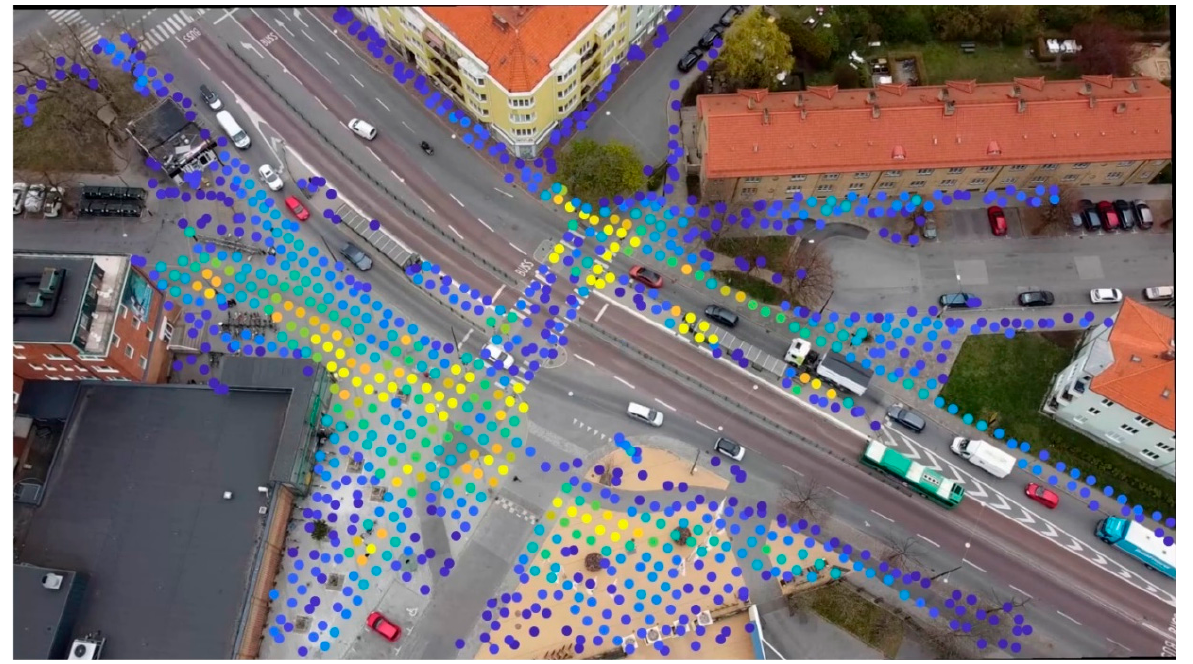
Figure 5. Pedestrian movement map at Folkets Park. Yellow indicates that more pedestrians were detected here during the analysis and blue indicates that fewer pedestrians were detected.